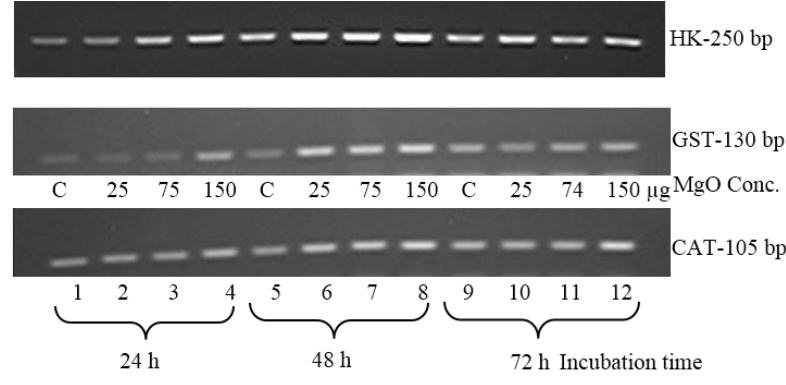
Figure 3. Gene expressions of GST and catalase of HepG2 on agarose gel. Expression of GST and catalase bands of HepG2 cell samples at 30 cycles amplification of cDNA.